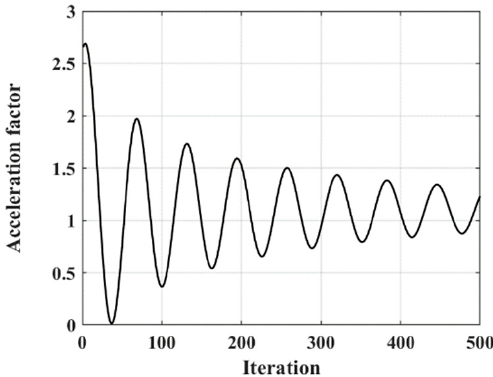
Figure 2. Change curve of acceleration factor.